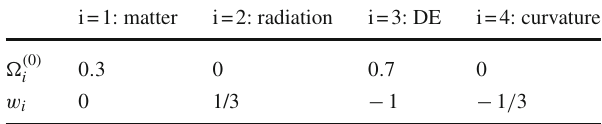
Table 1 EoS coefficients and density parameters in (cid:2)